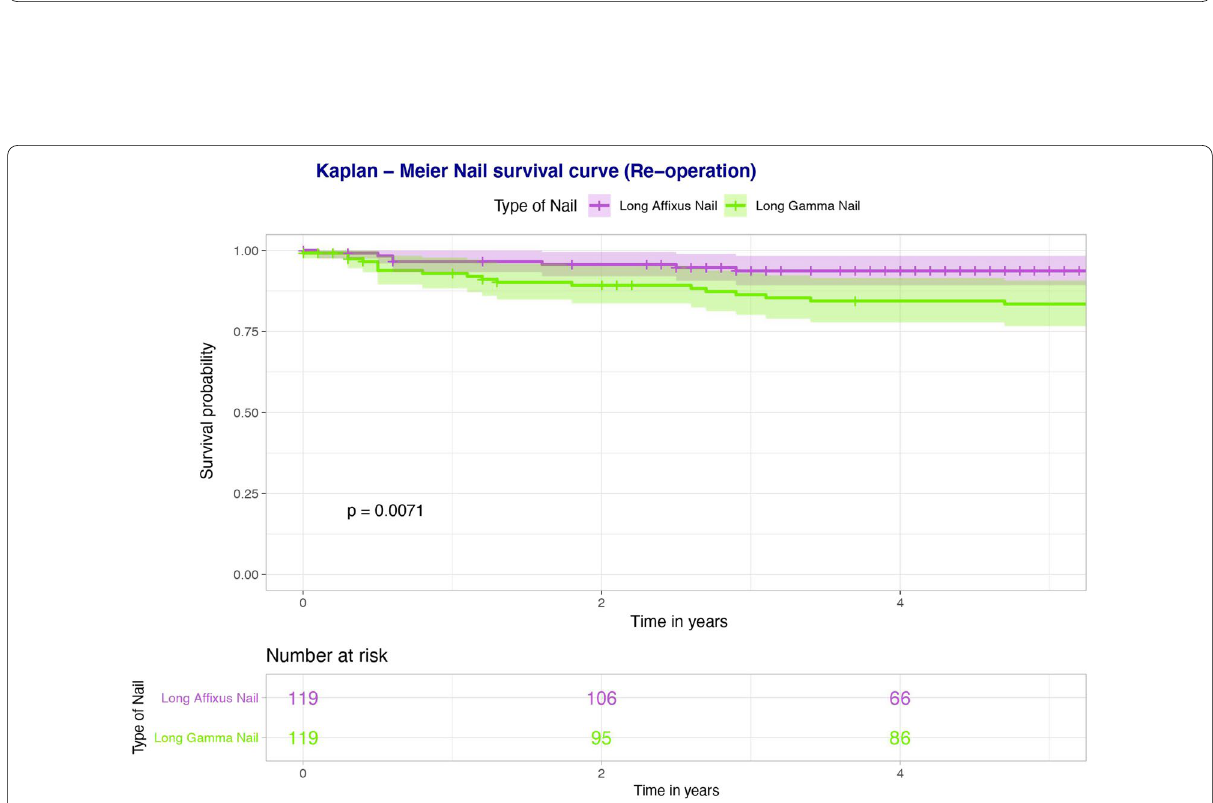
Fig. 3 Kaplan–Meier survival curve of re-operation due to nail-failure only. The height of each KM curve represents the 95% confidence interval for each nail